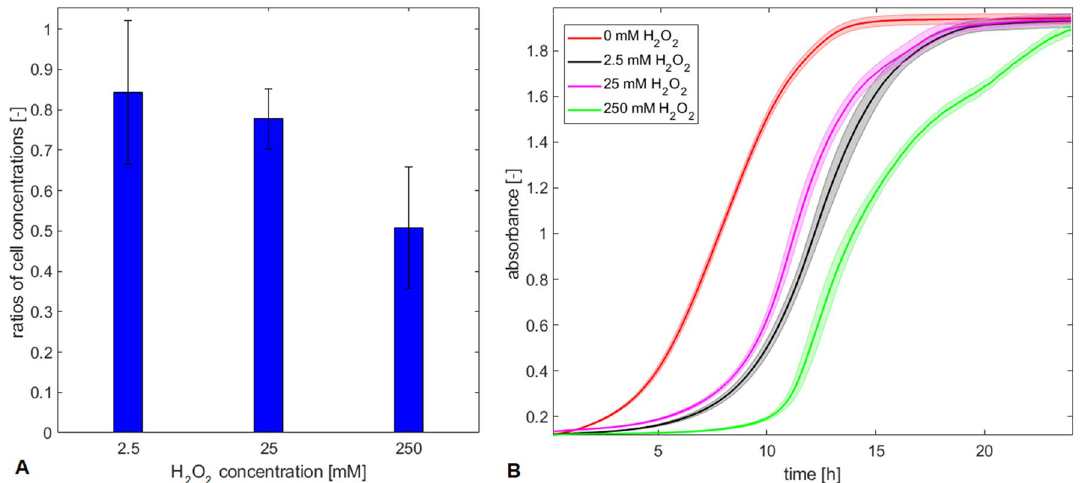
Figure 4. Cell concentration and cell culture growth after chemically induced oxidation treatment. ( A ) Ratios of cell concentration in the oxidized sample to concentration in the control sample after oxidation treatment. ( B ) Cell culture growth after oxidation treatment. The data represent mean values from n = 4 repetitions ( A ) and from n = 12 repetitions ( B ) of each experiment and the error bars constitute the standard